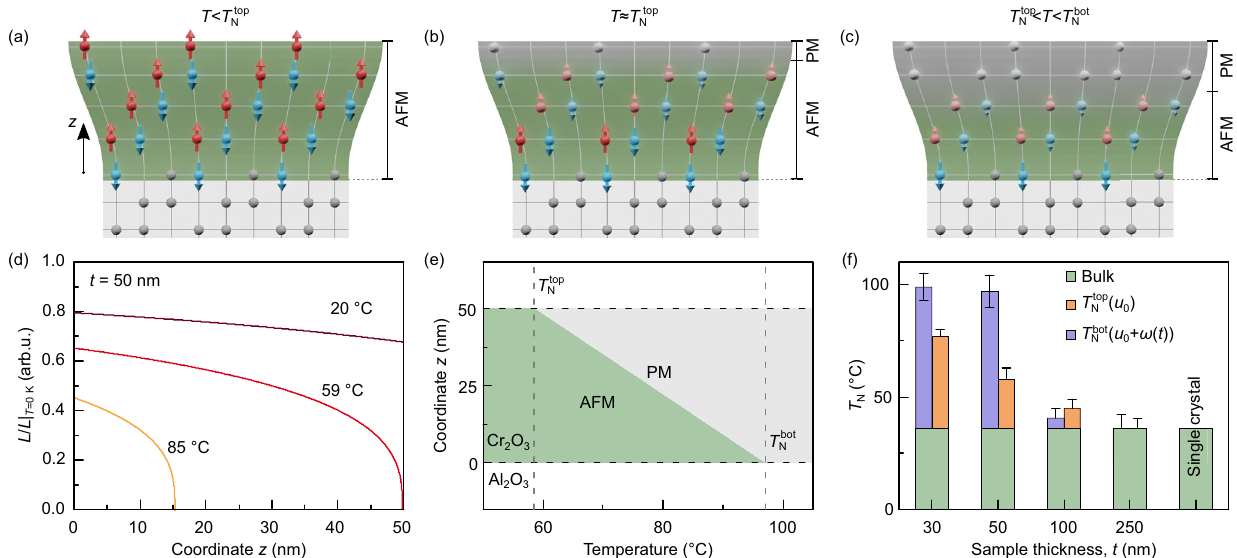
Fig.4|Impactofthestraingradientontheantiferromagnet-paramagnetphase transitioninCr 2 O 3 thin fi lms.a – c Schematicsoftheantiferromagnet-paramagnet phase transition. a At temperatures below T top N , the entire sample is anti- ferromagnetically ordered. b With the increase in temperature to about T top N , the less strained part of the sample (top region) undergoes a phase transition into the paramagnetic state. The bottom part of the sample remains antiferromagnetically ordered. c The portion of the sample in the ordered state is determined by the temperature. The sample turns into the paramagnetic state for T > T bot N . d The change of the length of the antiferromagnetic order parameter L along the fi lm thickness for a 50-nm-thick Cr 2 O 3 thin fi lm. The brown/red/orange curves corre- spond to the states shown in ( a – c ), respectively. e The portion of the 50-nm-thick fi lm,whichremainsintheantiferromagneticstate,dependentonthemeasurement